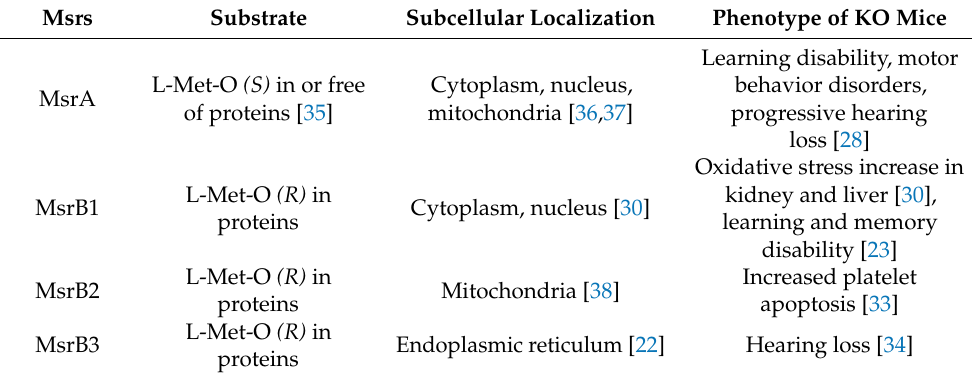
Table 1. The phenotypes of Msrs knockout (KO)